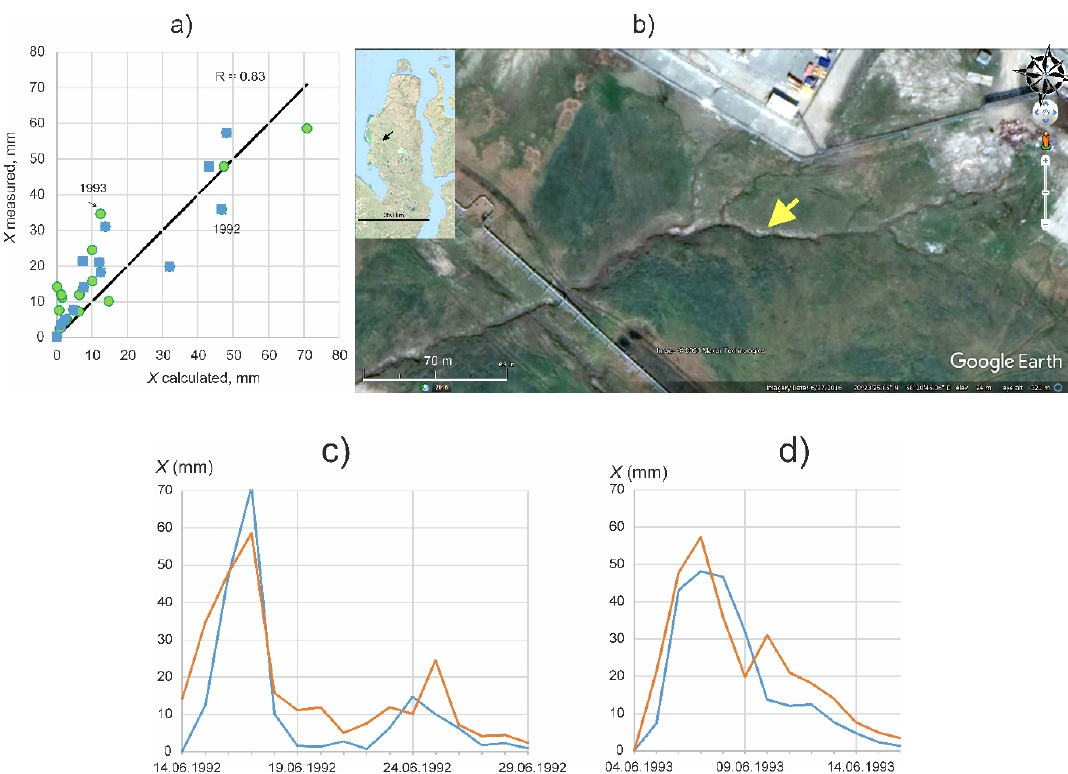
Figure 6. The comparison of the surface runoff depth calculated with the model, taking the melt coefficient k sm = 1.25 × 10 −4 and measured daily runoff depth Xs (mm) during snow thaw periods of the years 1992 and 1993 ( a ) at the headwaters of the Anthropogenic gully on the Yamal peninsula ( b ). The lower figures show the calculated (blue lines) and measured (red lines) hydrographs for the years 1992 ( c ) and 1993 ( d ).